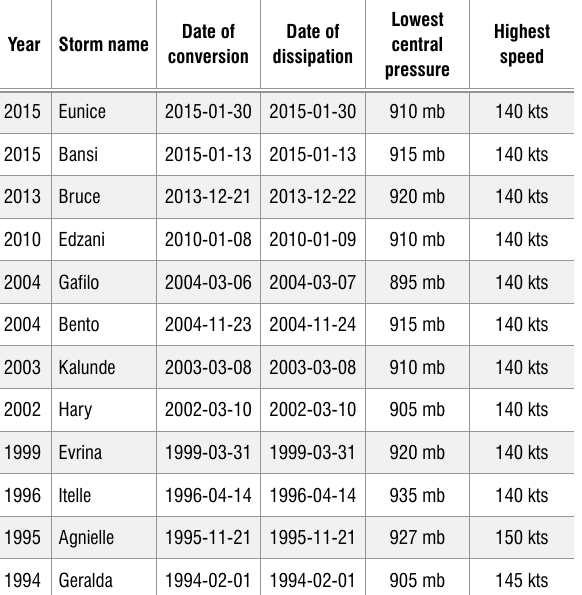
Summary of the CAT5 tropical cyclones recorded in the IBTrACS storm track database